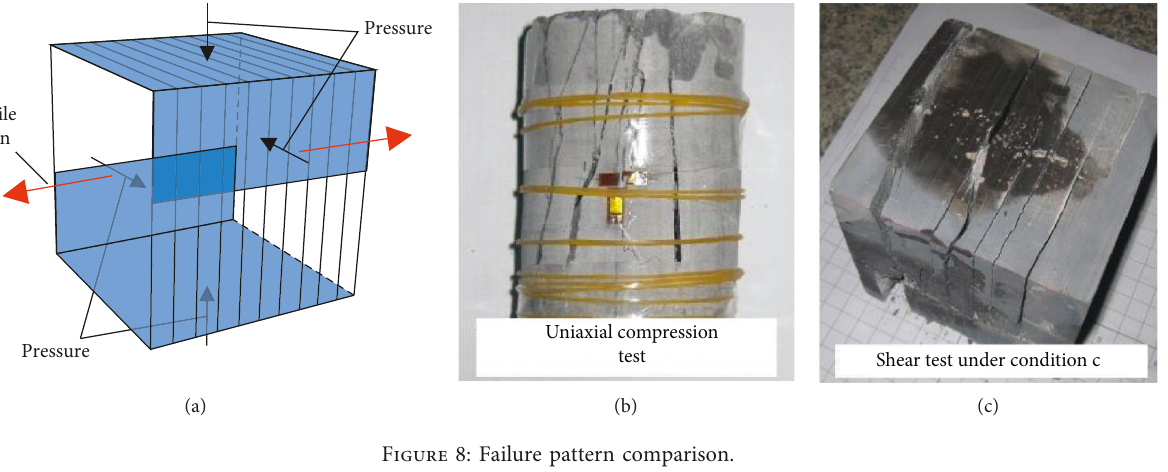
Figure 8: Failure pattern comparison.